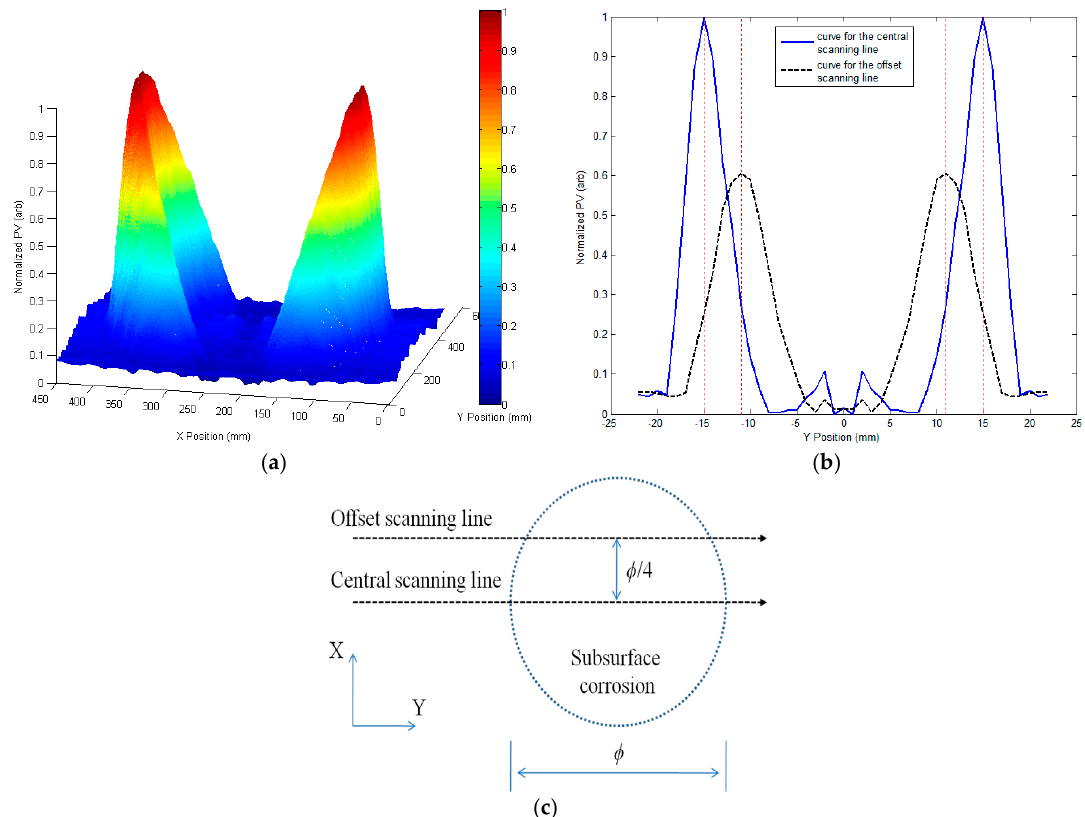
Figure 9. Peak values (PVs) of g x ( B x ) vs. probe positions. ( a ) Scanning curves for Corrosion #1; ( b ) scanning curves along the central and offset scanning lines; ( c ) schematic illustration of the central and offset scanning lines.